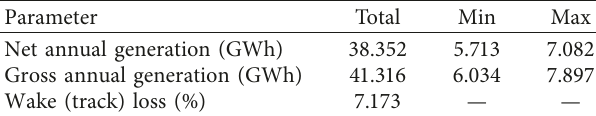
Table 3: Annual generation values of 6 V80 wind turbines. Parameter